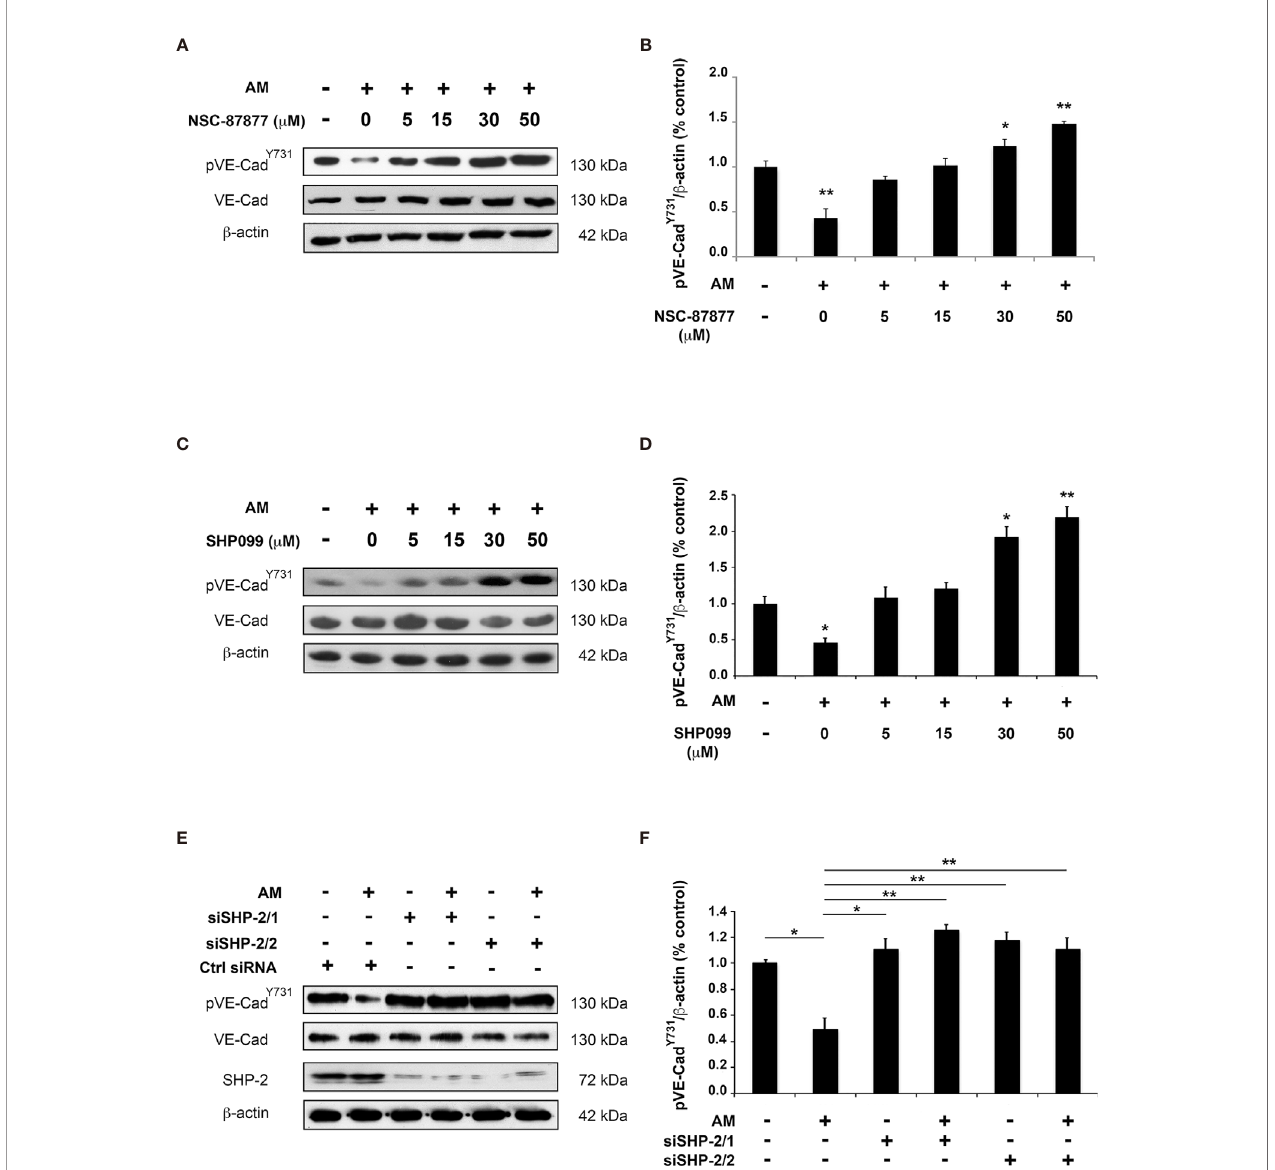
FIGURE 3 | Inhibition of SHP-2 impairs AM-induced dephosphorylation for pVE-cadherin Y731 in HUVECs in vitro . (A, C) HUVECs were pre-incubated for 3 h with increasing concentration of SHP-2 inhibitors NSC-87877 (A) or SHP099 (C) and then treated with AM (10 -9 M) for 6 h, followed by immunoblotting for VE-cadherin and pVE-cadherin Y731 , as indicated on the left. Blotting for b -actin was used to control equal loading. (B, D) Relative changes in the pVE-cadherin Y731 levels were assessed by quanti fi cation of immunoblots from fi ve independent experiments. The value of control cells was set to 100%. * p < 0.05; ** p < 0.01. (E, F) HUVECs were transfected with control siRNA (Ctrl siRNA) or with siRNAs directed against SHP-2. 48h later, cells were treated with AM (10 -9 M) for 3 h and cell lysates were immunoblotted for pVE-cadherin Y731 , VE-cadherin, and SHP-2, as indicated on the left. Blotting for b -actin was used to control equal loading. * p < 0.05; ** p < 0.01. Each experiment is representative of fi ve (B, D) , and four (E) independent experiments. Results are shown as means ±